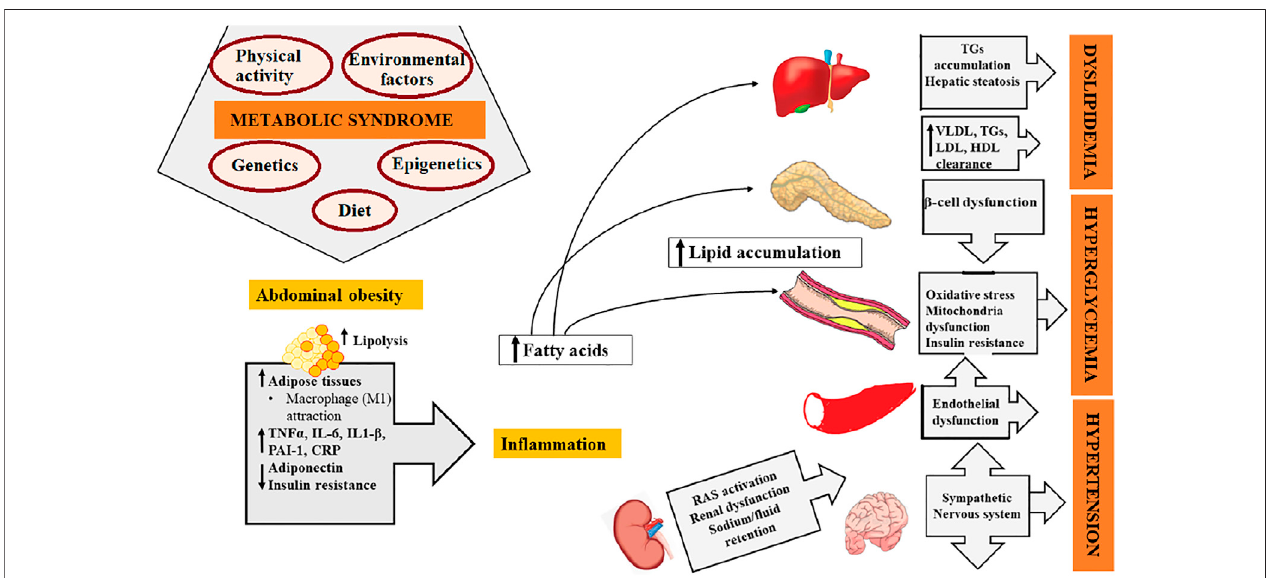
FIGURE 1 | Overview of metabolic